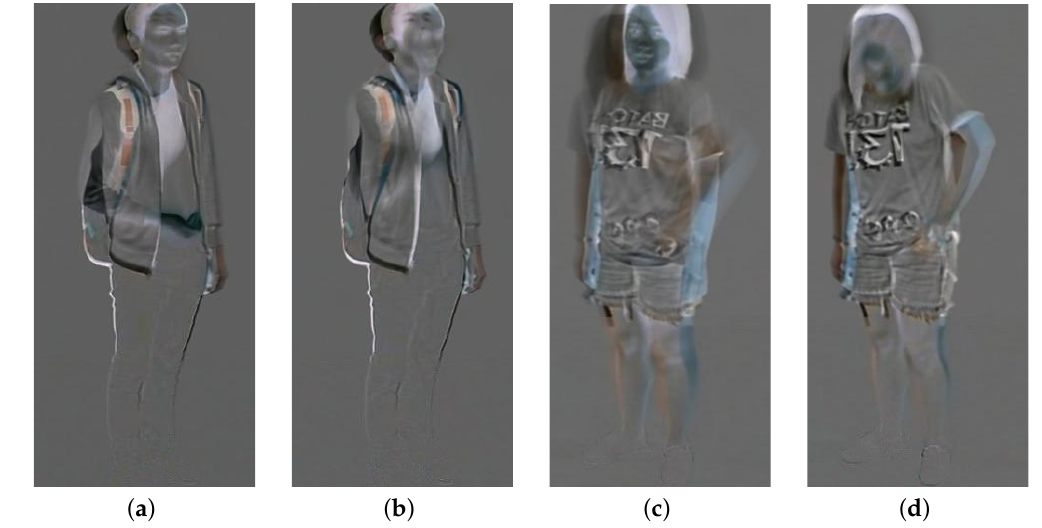
Figure 2. The dynamic images of action from the NTU RGB + D Dataset. ( a ) a